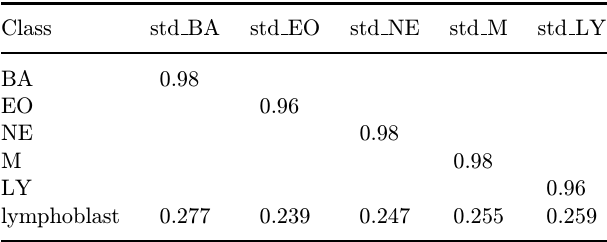
Table 1. Spectral matching score from the test.